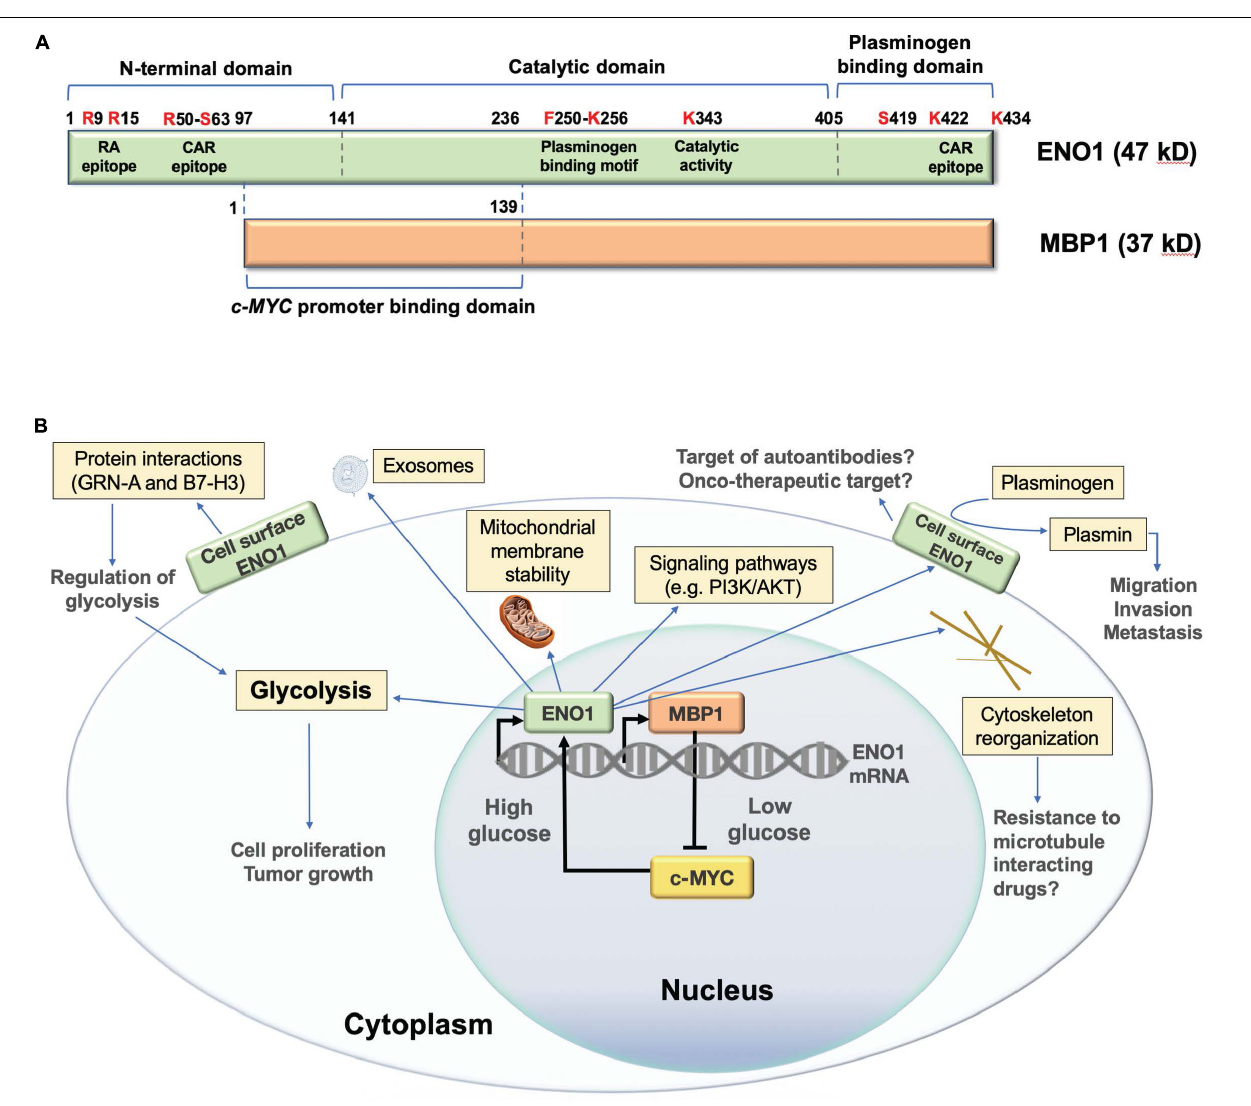
FIGURE 1 | Structure and functions of human ENO1. (A) Schematic representation of domain structure of ENO1 and its alternative translation variant c-MYC promoter binding protein 1 (MBP1). Several lysine residues (K256, K422, and K434) have been implicated in the plasminogen binding functions of ENO1, whereas K343 has been implicated in its catalytic activity, required for the conversion of 2-phosphoglycerate to phosphoenolpyruvate during glycolysis. Citrullination of arginines 9 (R9) and 15 (R15) generates an immunodominant peptide (residues 5–22) that is targeted by autoantibodies in patients with rheumatoid arthritis. Methylation of arginine 50 (R50) has been implicated in ENO1 externalization. R50 is also part of an immunodominant epitope recognized by autoantibodies from patients with cancer associated retinopathy (CAR). Another CAR epitope is located within the plasminogen binding domain. Phosphorylated serine 419 (S419) within the plasminogen binding domain is recognized of ENO1 autoantibodies in pancreatic cancer patients. While MBP1 shares the catalytic and plasminogen binding domains of ENO1, it lacks these functions due to its exclusive nuclear localization. MPB1 residues 1–139 (ENO1 96–236) comprise its DNA binding domain, required for binding to the c-MYC gene promoter, which results in repression of promoter activity and downregulation of c-MYC protein expression. (B) Schematic representation of the cellular functions of ENO1 and MBP1. MBP1 localizes primarily in the cell nucleus where it represses the c-MYC gene promoter, whose activity is essential for ENO1 upregulation. ENO1 is primarily localized in the cytoplasm, where it functions in glycolysis, promoting mitochondrial stability and cytoskeleton reorganization, and regulating oncogenic signaling pathways. This protein is also localized on the cell surface, where it acts as a plasminogen receptor and interacting partner of various proteins to regulate glycolysis, as well as cancer cell migration, invasion, and metastasis. ENO1 can also be secreted from cells as a component of exosomal